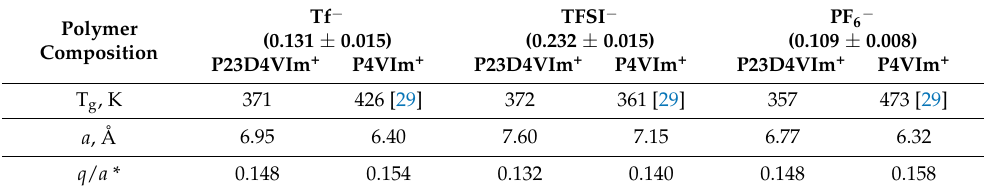
Table 2. Poly(1-butyl-2,3-dimethyl-4-vinylimidazolium) and poly(1-ethyl-3-methyl-4-vinylimidazolium) salts.